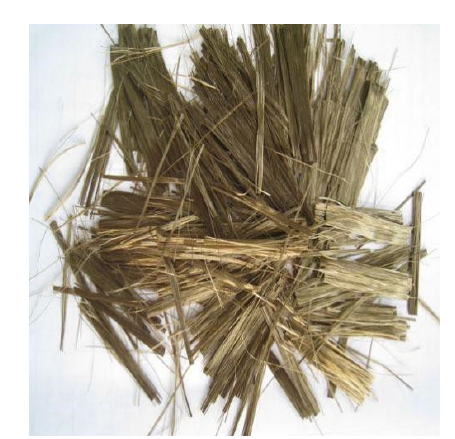
Figure 4. Basalt fibers.